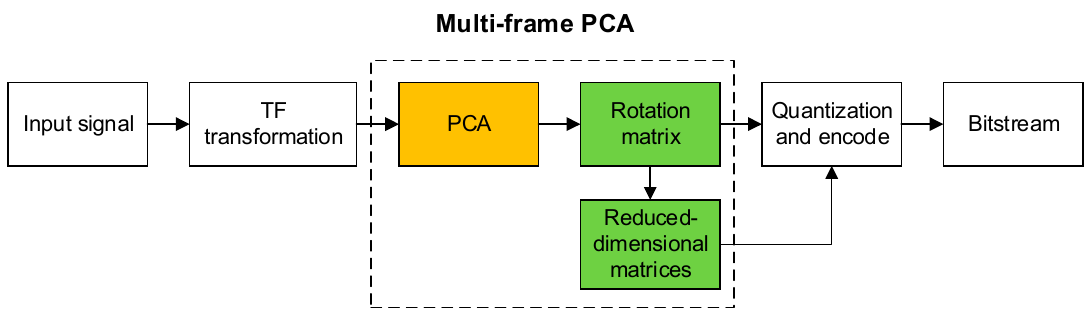
Figure 1. Flowchart of mono encoder. (TF, Time-to-Frequency; PCA, Principle Component Analysis).